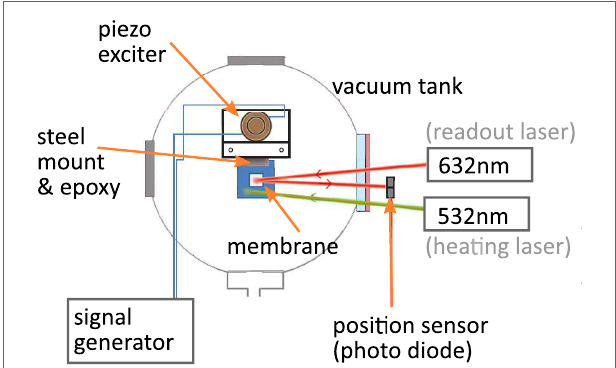
FIGURE 4 | Schematic of the experimental setup used to measure the frequency shift caused by laser heating of the membrane frame with the 532nm